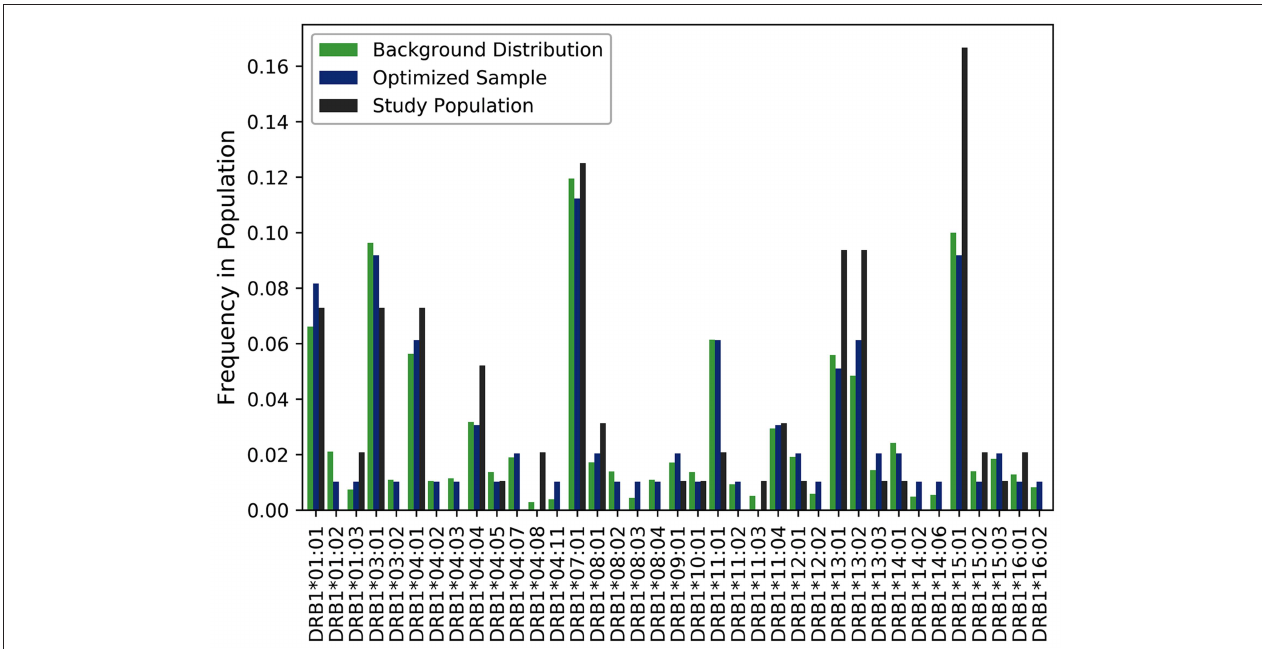
FIGURE 4 | Optimizing selection of a hand-picked donor cohort. A cohort of 50 HLA-typed donors were used in a T-cell proliferation and ELISA assay to assess the T-cell responses of three variants engineered to reduce the immunogenicity of a FVIIa. The frequency of each allele found in the assay is shown in black. The frequency of each allele in the optimized sample is shown in blue. The frequency of each allele in the background distribution of alleles in the North American population is shown in green. The use of our algorithm resulted in a reduction of JSD from 0.198244 in the hand-picked sample to 0.111660 in the optimized sample when each was compared to the background distribution of HLA variants in the US